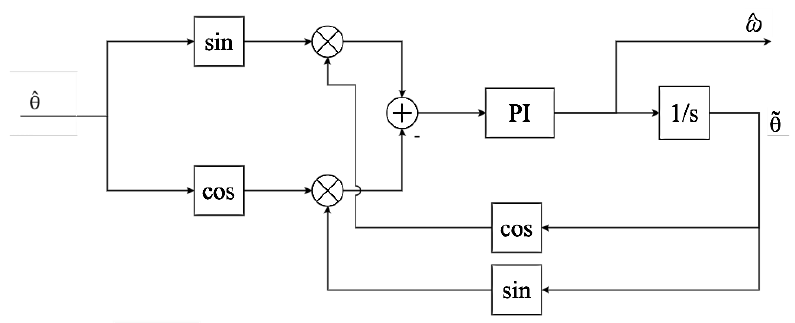
Figure 4. PLL commonly used for speed estimation.